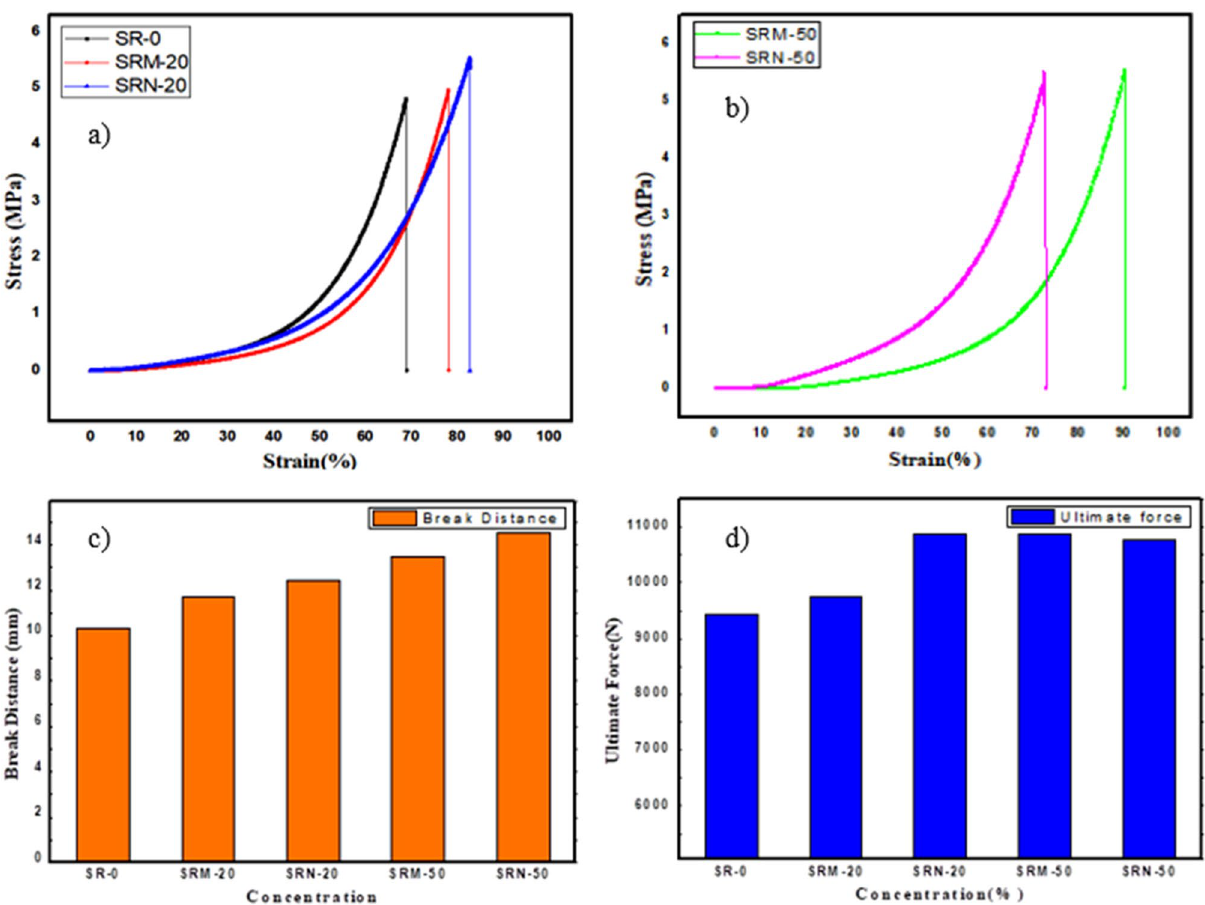
Figure 5. The mechanical properties of free silicon rubber and with different concentration of micro and nano lead oxide ( a ) Stress-Strain curve for SR-0 and both SR-20, ( b ) Stress-Strain curve for SR-50, ( c ) break distance as a function of PbO concentration, ( d ) Ultimate force as a function of PbO